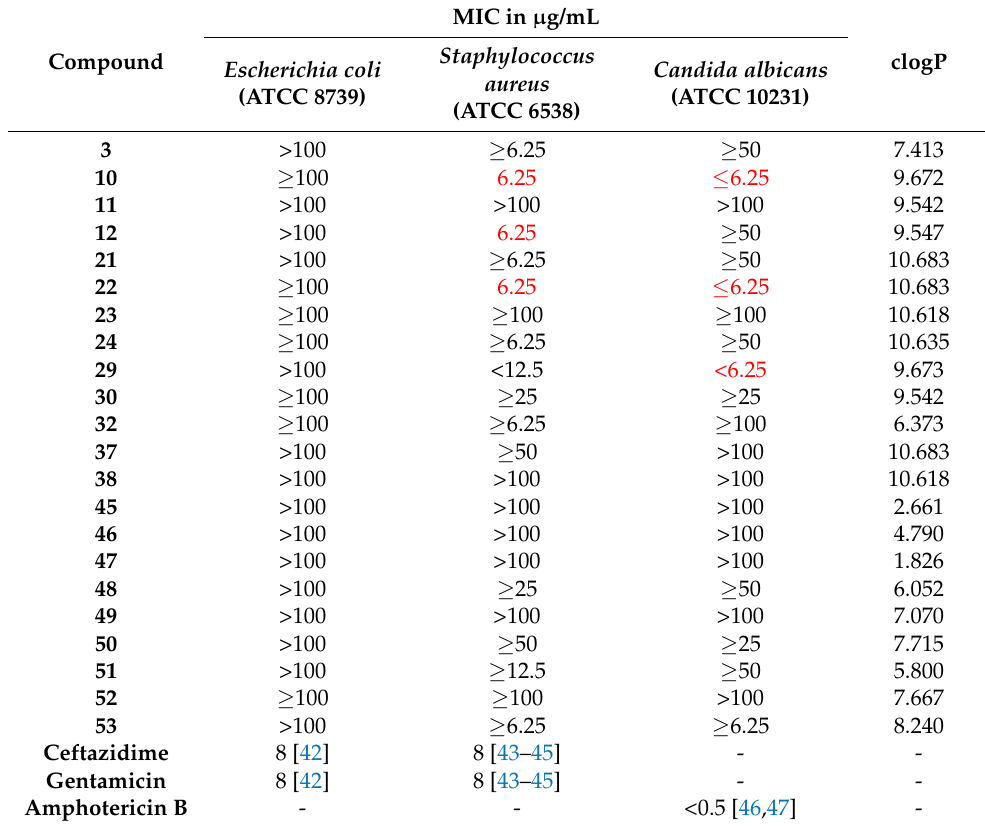
Table 2. Antibacterial and antifungal activity. (MIC values given in µ g/mL, >larger than, <smaller